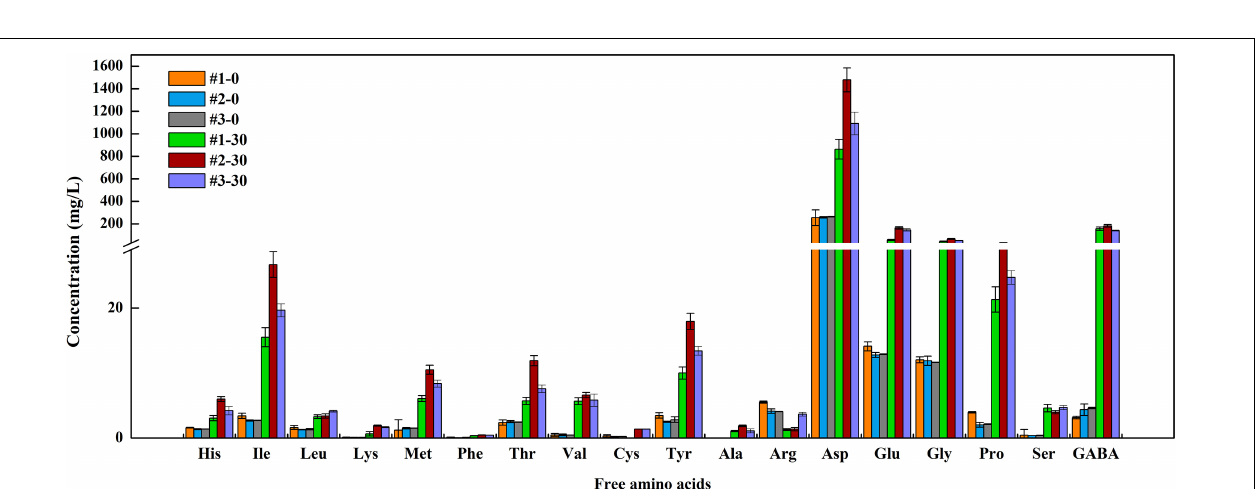
FIGURE 5 | The concentration of free amino acids (FAAs) in different homemade northeast sauerkraut at days 0 and 30. #1, #2, and #3 represented three different households. The number behind “ − ” (0, 30) represented fermentation time (day).